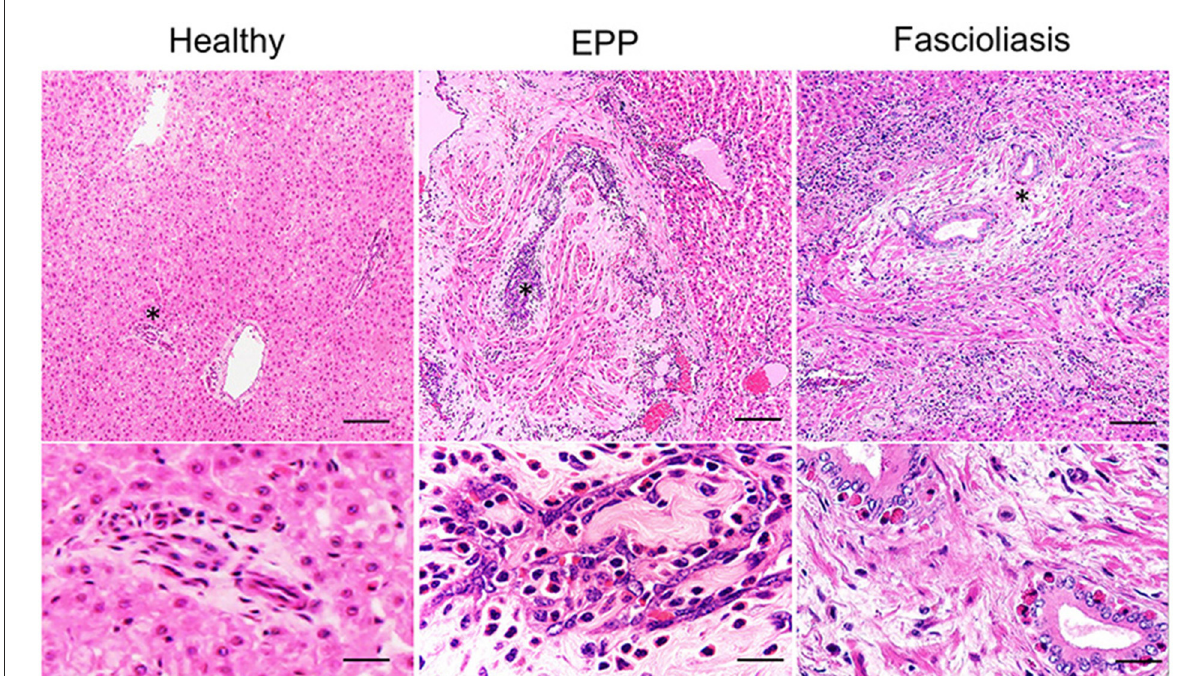
FIGURE1 Hematoxylin–eosin (HE) staining images of the hepatic interlobular triad region in a healthy liver, an eosinophilic proliferative phlebitis (EPP) case, and a chronic fascioliasis case. Mild eosinophilic infiltration is observed in the hepatic interlobular triad area in healthy cattle (Healthy). In EPP cattle, portal vein branches show irregularly dilated lumens and aberrant intimal proliferation, with concomitant extensive endothelial hyperplasia, intimal fibrosis, vascular smooth muscle hyperplasia, and severe eosinophilic infiltration in the endothelium. In fascioliasis cattle (Fascioliasis), the biliary epitheliums show papillary and glandular hyperplasia, accompanied by fibrosis and accumulation on the biliary epithelium by moderate infiltration of mononuclear cells and eosinophil. High-magnification image is indicated at the bottom with an asterisk (*). Each scale bar indicates 50 µ m in low-magnification images and 10 µ m in high-magnification images.